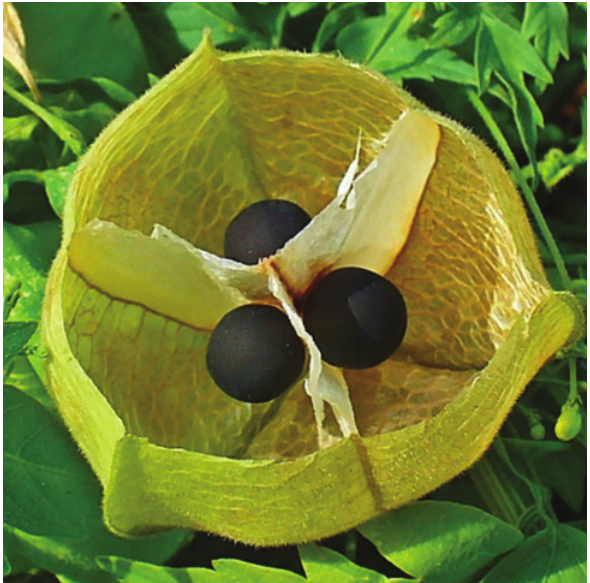
Figure 1. Interior of fruiting capsule of balloon vine C. halicacabum. The upper portion of the capsule wall has been trimmed away and shows the central position of the seeds. The ‘fruit size’ variable we meas- ured was the shortest distance from the fruit capsule perimeter to the seed coat for each seed. The second species in this study, Cardiospermum grandiflorum , has larger fruits of similar architecture (Image source: Wikimedia commons: Cardiospermum halicacabum